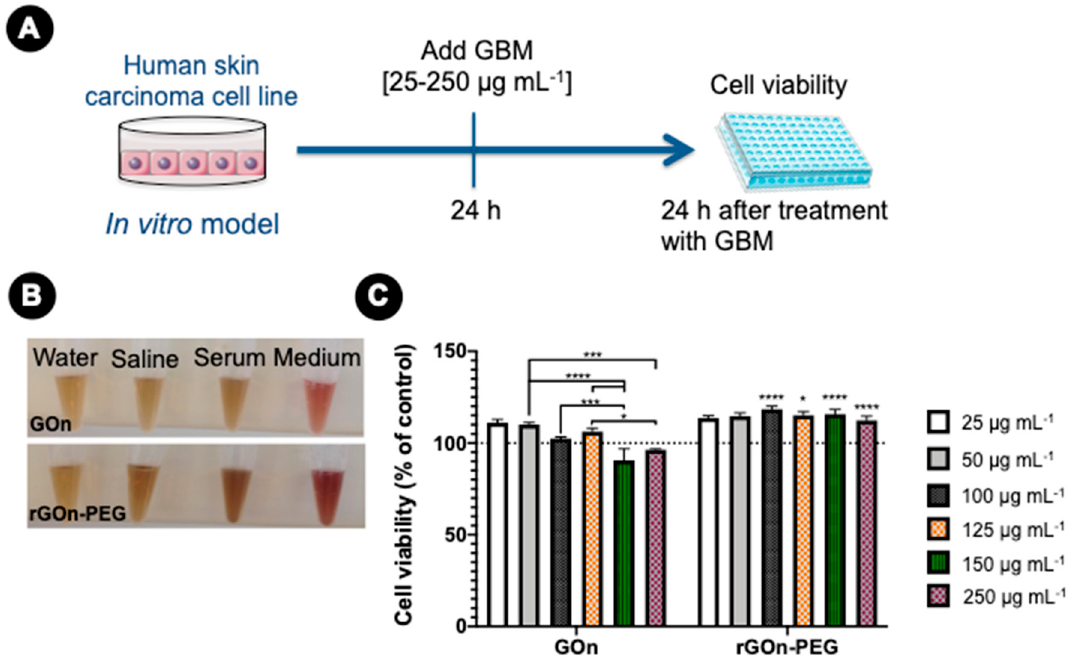
Figure 7. GBM biocompatibility. ( A ) Experimental set-up. One day (24 h) after seeding, human skin carcinoma cells (A-431) were treated with di ff erent concentrations of GOn and rGOn-PEG and incubated for an additional 24-h period, prior to resazurin assay. ( B ) GOn and rGOn-PEG (250 µ g mL − 1 ) in water and physiological solutions. ( C ) Cellular viability determined using resazurin assay. Results are normalized with respect to values of the control without GBM. Statistically significant di ff erences are shown as * p < 0.05, *** p < 0.001, **** p < 0.0001. Dashed line represents 100% cell viability of the control without GBM.